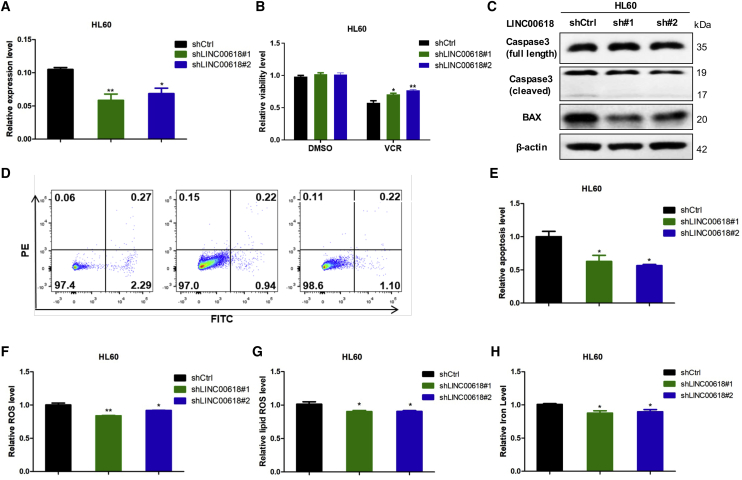
Knockdown of LINC00618 Inhibits Cell Apoptosis and Ferroptosis(A) qRT-PCR analyses of stably knockdown vector and LINC00618 in HL60 cells. (B) Statistical analysis of cell viability in HL60 cells stably overexpressing LINC00618 and treated by VCR at 48 h. DMSO served as control. (C) Western blot analyses of caspase-3 and BAX protein levels in HL60 cells after the knockdown of LINC00618. (D and E) FACS (D) and statistical analysis (E) showed that LINC00618 promoted early apoptosis in HL60 cells after the knockdown of LINC00618. (F) FACS and statistical analysis of relative ROS level in HL60 cells after the knockdown of LINC00618. (G) FACS and statistical analysis of relative lipid ROS level in HL60 cells after the knockdown of LINC00618. (H) Relative iron level checked by an Iron Assay Kit in HL60 cells after the knockdown of LINC00618. Data are shown as the mean ± SEM; n ≥ 3 independent experiments, two-tailed Student’s t test: ns, nonsignificant (p > 0.05), ∗p < 0.05, ∗∗p < 0.01, ∗∗∗p < 0.001.